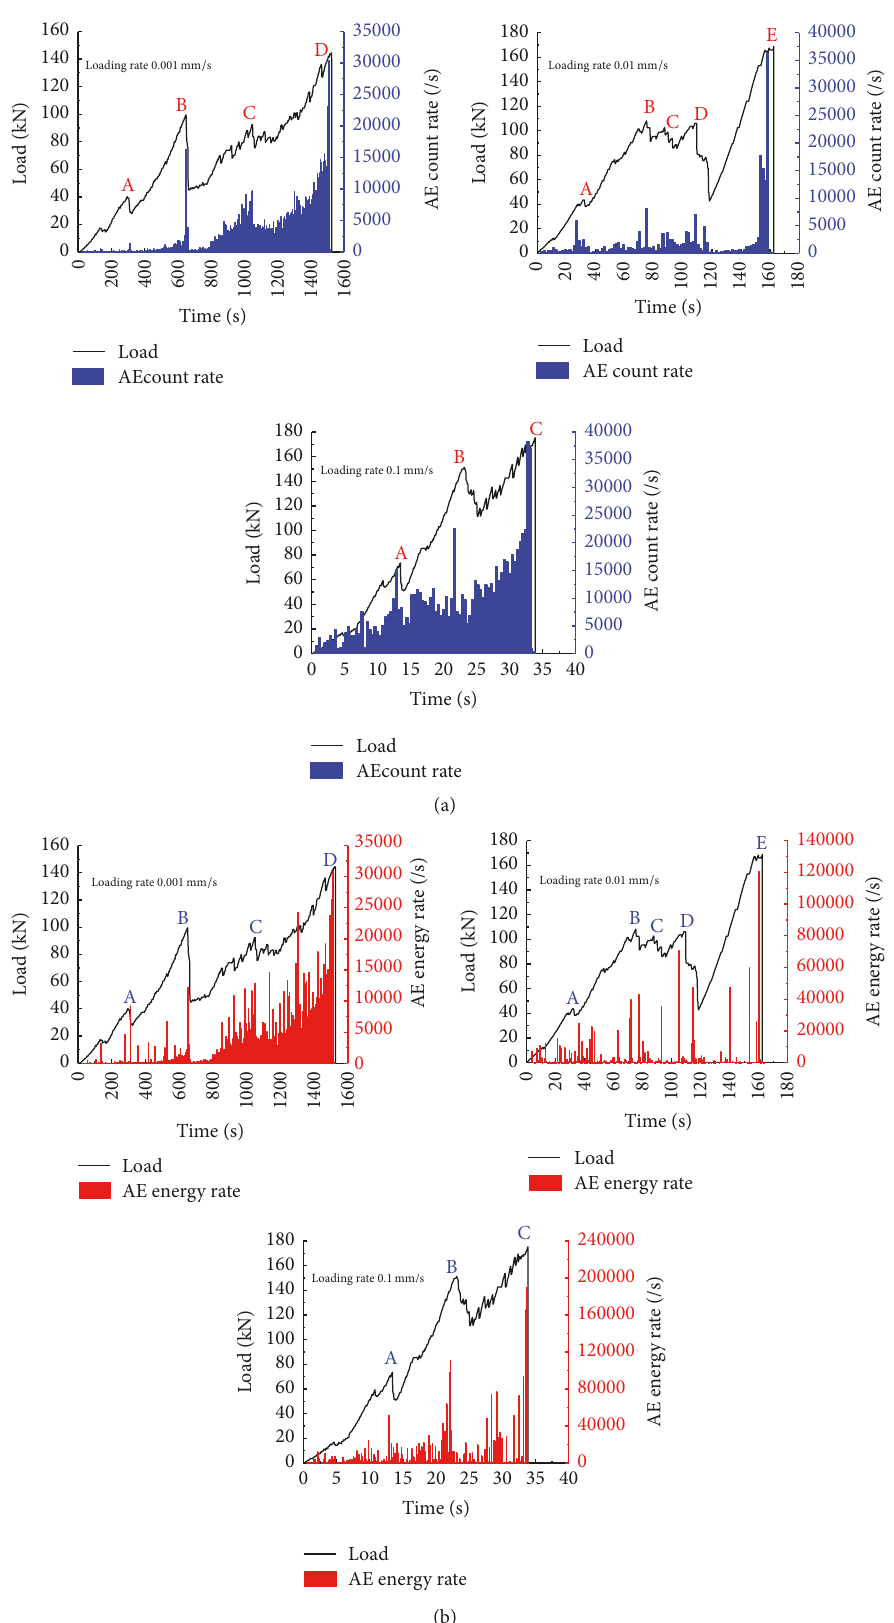
Figure 2: Curves of AE parameters under different loading